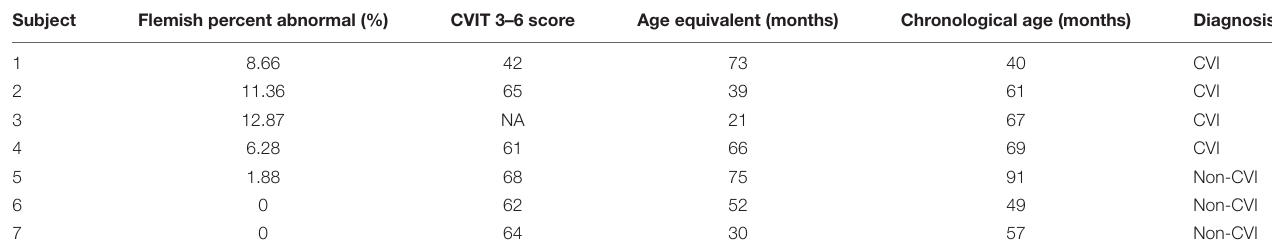
TABLE 2 | Summary of collected data in all